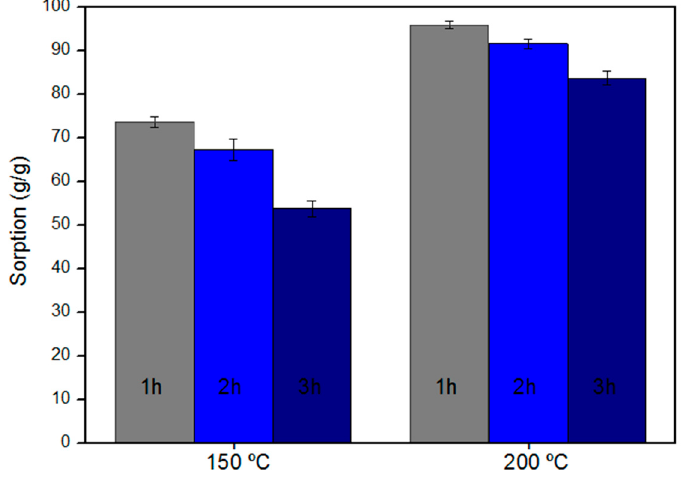
Figure 1. Paraffin sorption capacity of CP fiber treated at 200 °C and 150 °C varying the duration of the heat treatment in 1 h, 2 h, and 3 h, for the fiber/oil contact time of 1 h. It is observed in Figure 1 that increasing the treatment temperature from 150 °C to 200 °C increased the paraffin sorption capacity from 30 to 57% for all the duration of the